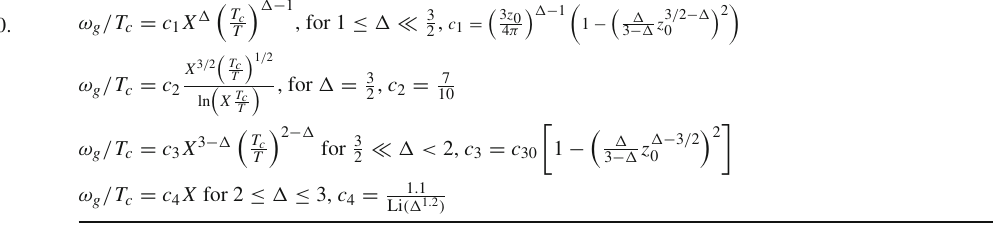
Table 3 ω g / T c as function of /(cid:2) (cid:3) O (cid:2) (cid:4) 1 /(cid:2) X = g 1 near T ≈ 0. T c